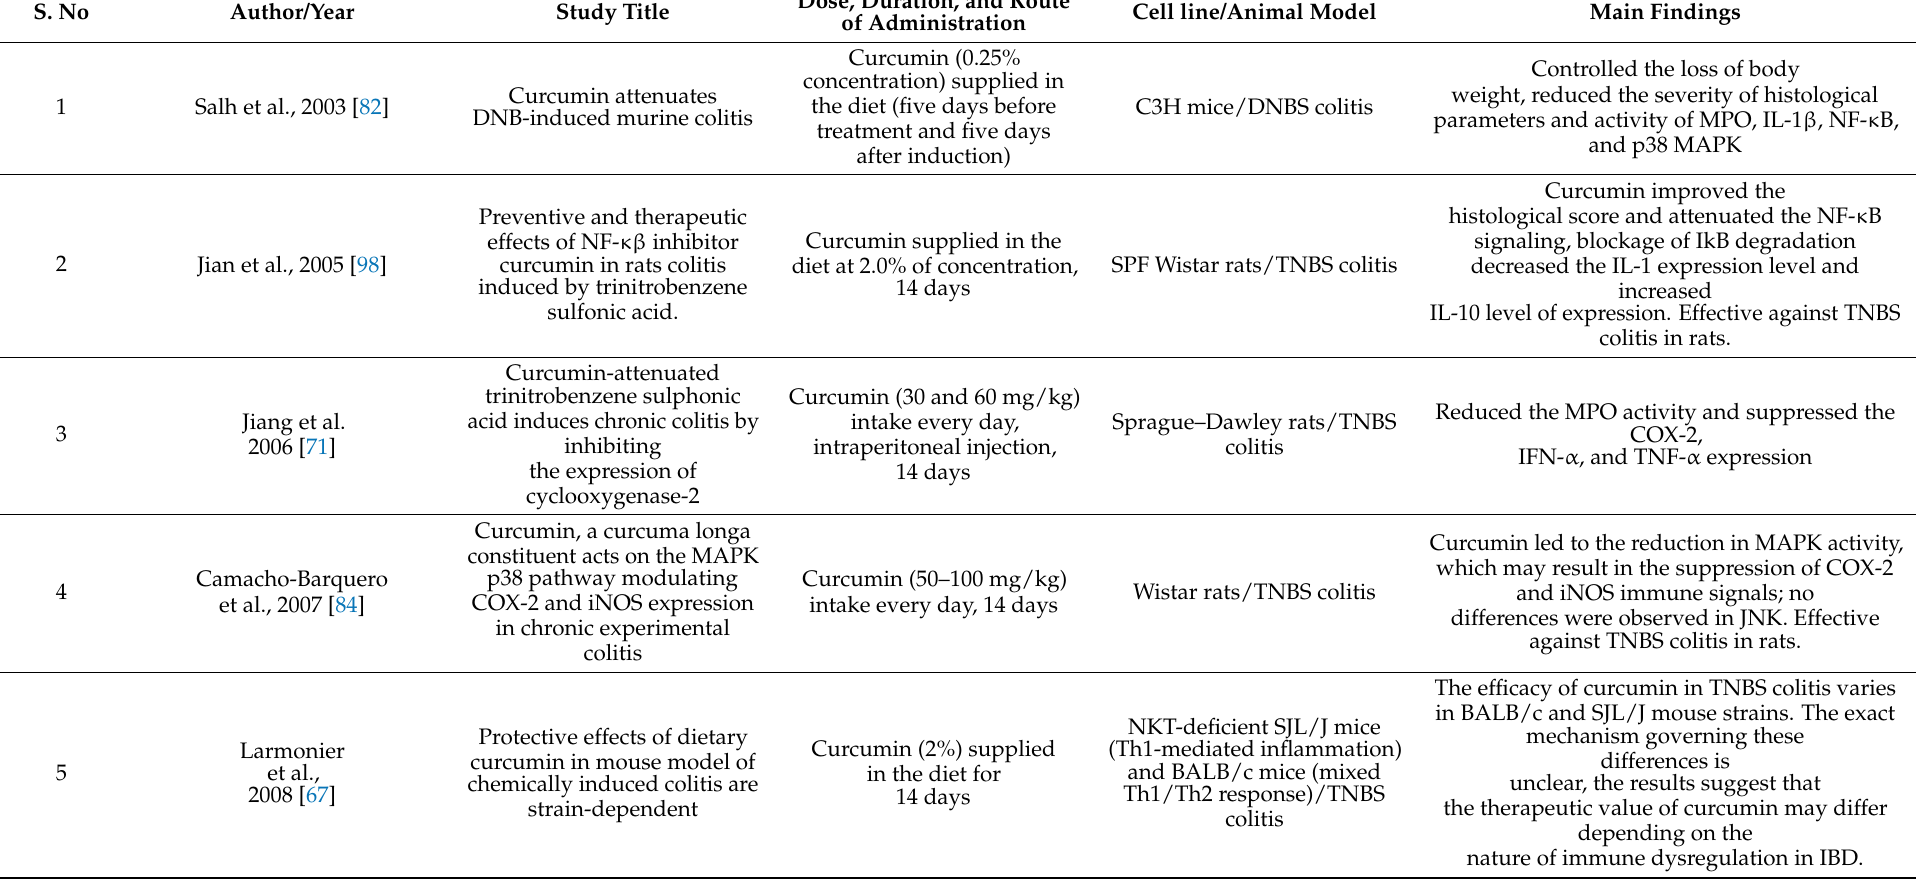
Table 3. Details of in vitro and animal studies of curcumin administration in inflammatory bowel disease